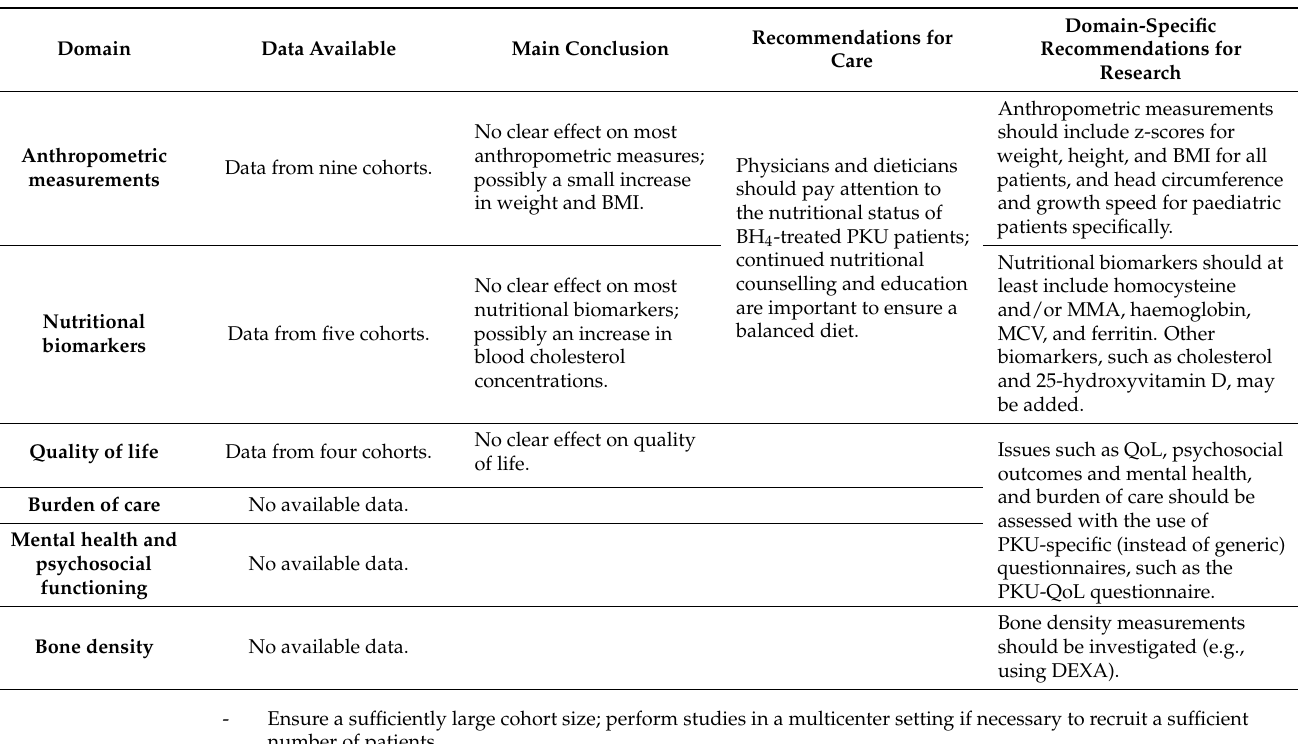
Table 6. Overview of our main findings, and recommendations for care and future research on dietary liberalization, resulting from adjuvant treatment options such as BH 4 , in PKU patients. BMI,